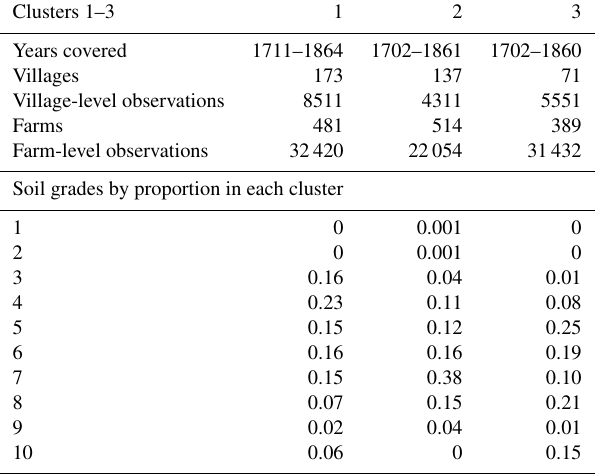
Table 1. Descriptive statistics for each cluster, including propor- tions of soils of different qualities.